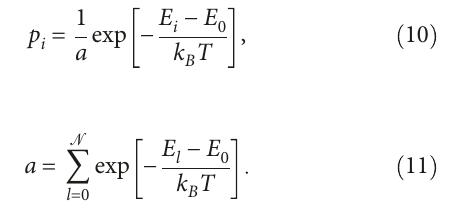
Figure 3: Initial state term schemes of Ti 3+ (3d 1 ) illustrating the e ff ect of the 3d SOC and an O atomic ground state term 2